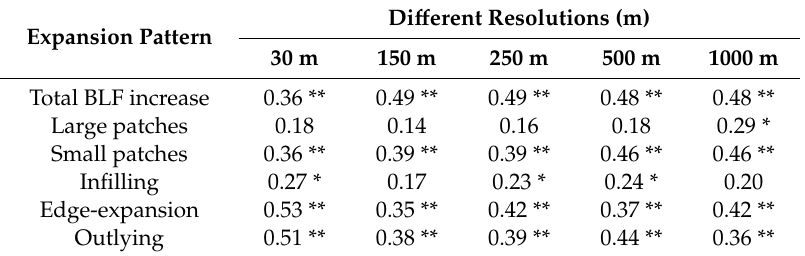
Table 6. Correlation coe ffi cients between BLF expansion patterns and flood occurrence at di ff erent spatial resolutions. Di ff erent Resolutions Expansion Pattern